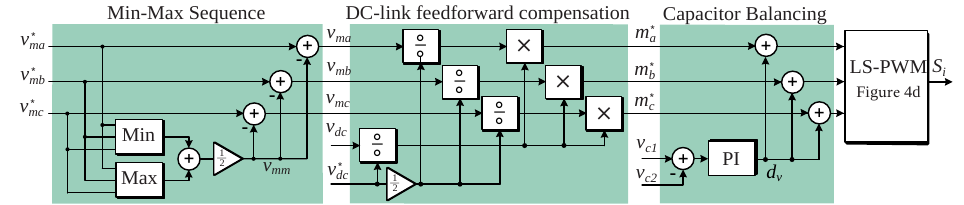
Figure 5. LS-PWM with min-max sequence and ripple feedforward